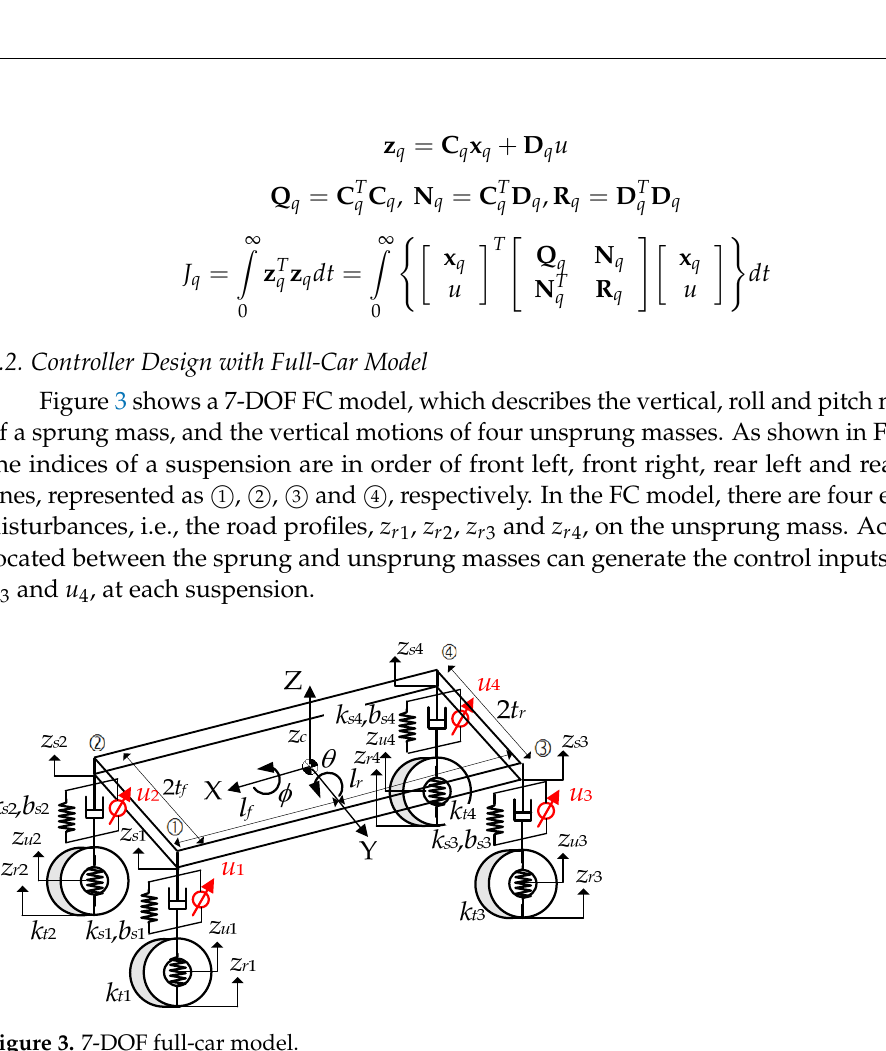
Figure 3. 7-DOF full-car model.